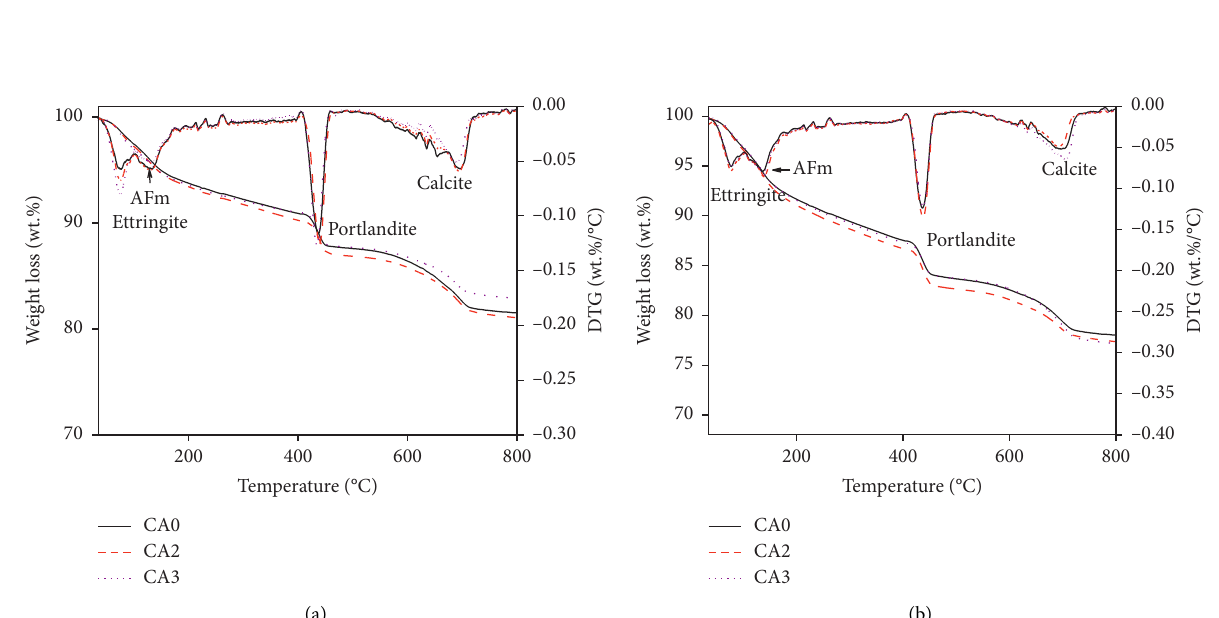
Figure 3: TGA results of the different groups after curing for (a) 3 days and (b) 28 days.